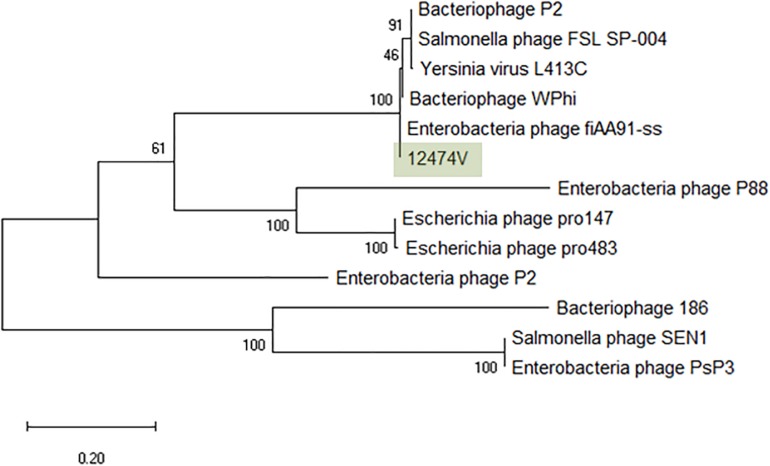
Phylogenetic tree of Peduovirus phage based on the Clustal Omega alignment of the integrase protein sequence of the representative phage vB_EcoM-12474V (MK907239). The percentage of trees in which the associated taxa clustered together is shown next to the branches. The list of genomes included and GenBank accession numbers are described in Supplementary Data S5.